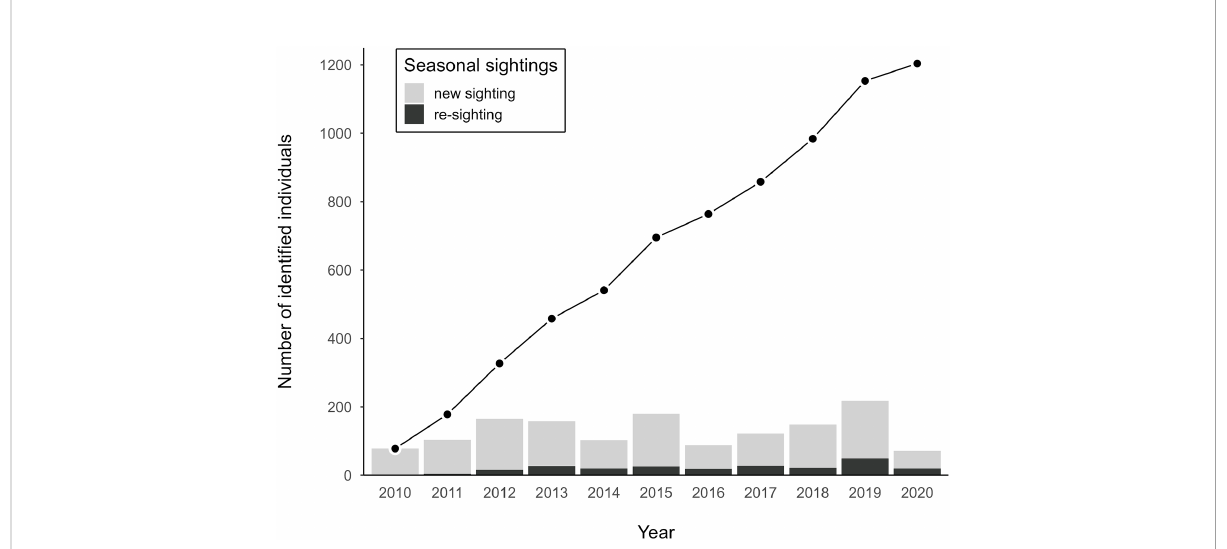
FIGURE 3 Discovery curve of the cumulative number of photo-identi fi ed individuals from 2010 to 2020 (points), with bar plots showing the number of new and previously identi fi ed (re-sighted) individuals seen each